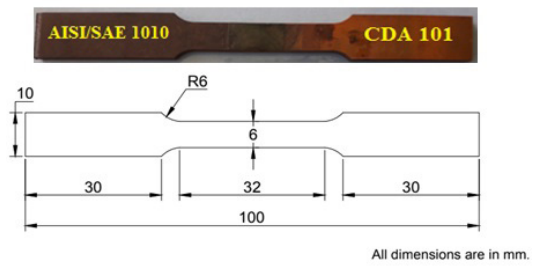
Figure 4. Dimensions [ASTM E8-04] of the tensile sample.